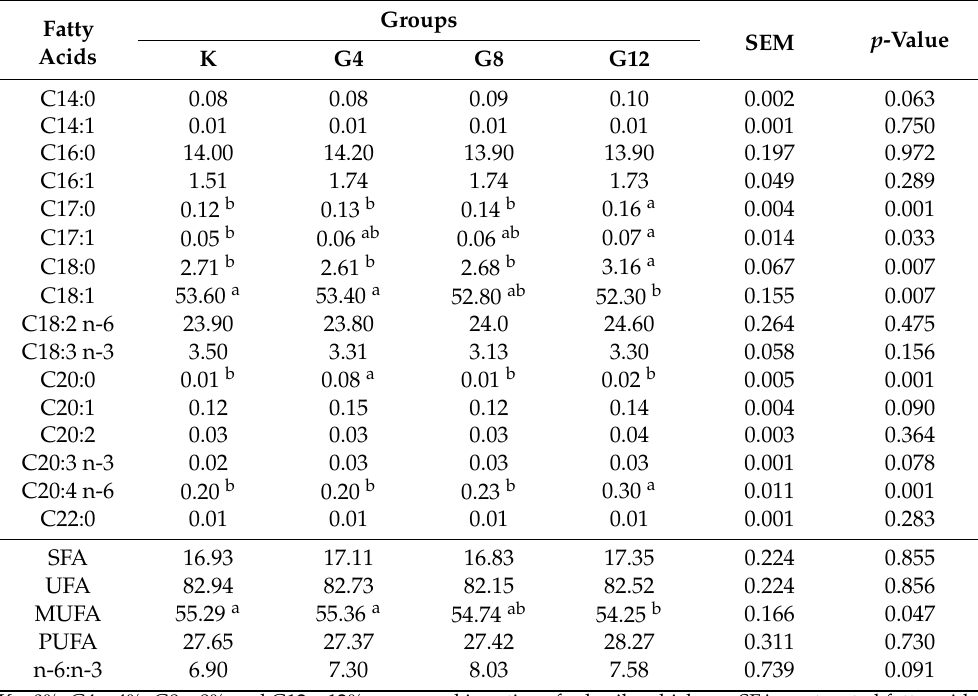
Table 9. Fatty acids profile (% of total fatty acids) in leg muscles of broiler chickens fed graded levels of guar